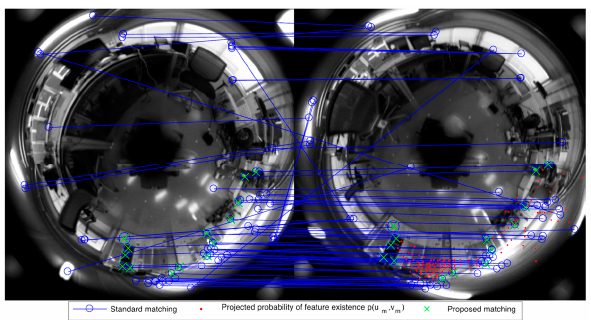
Figure 3. Example of dynamic matching. Standard matching [2] (blue) is compared with the proposal (green). Red points indicate the probability distribution for feature point existence, p(x,y,z) , projected onto the image